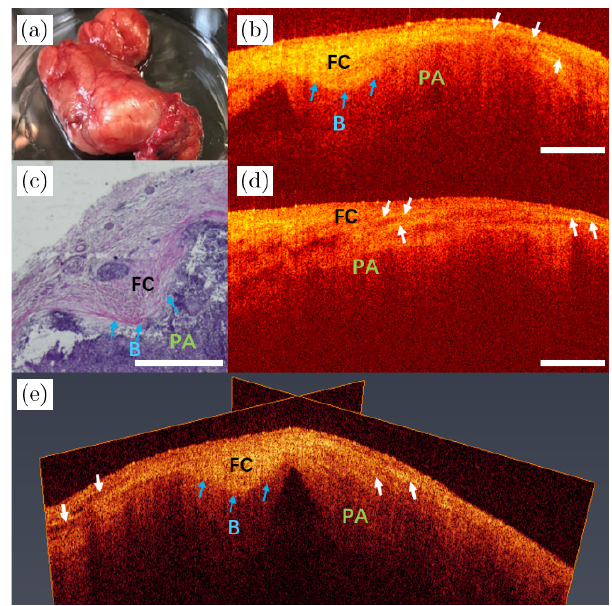
Fig. 8. Images of pleomorphic adenoma of submandibular gland. (a) The photo of the excised tissue. (b) and (d) Two 2D OCT images of di®erent positions of pleomorphic adenomas from the same sample. (c) Its histopathological image. (e) A 3D OCT image. PA: pleomorphic adenoma, FC: ¯brous capsule and B: boundary.